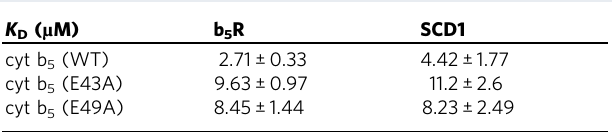
Table 1 Binding af fi nities of soluble cyt b 5 to SCD1 or soluble b 5